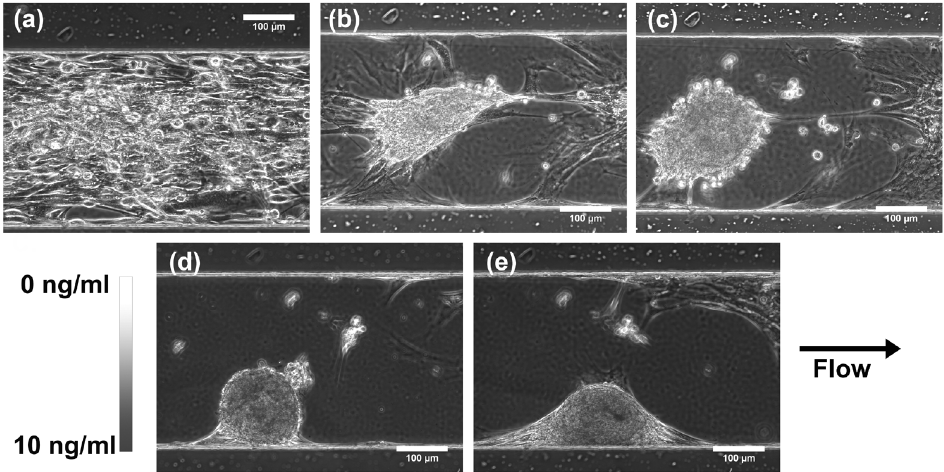
Figure 6. Effect of TGF- β1 gradient on MSC chondrogenesis. Phase contrast images of a region within the gradient device on ( a ) day 1 (just prior to TGF- β1 gradient exposure),